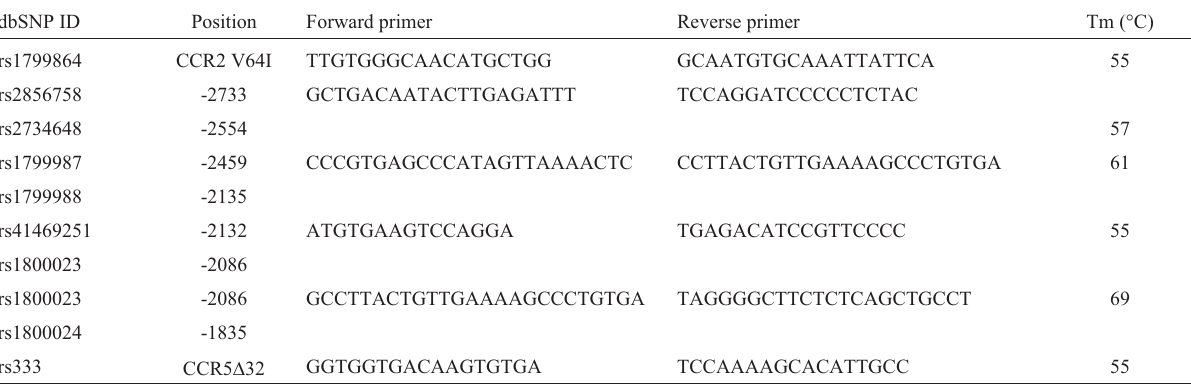
Table 1 - Primer sequences used for PCR and sequencing